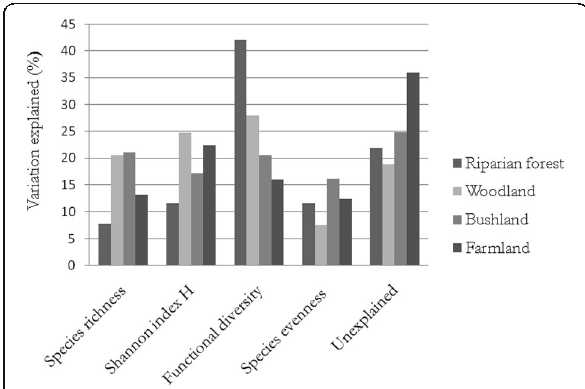
Fig. 2 Proportion of aboveground carbon storage variation explained by different land cover types in